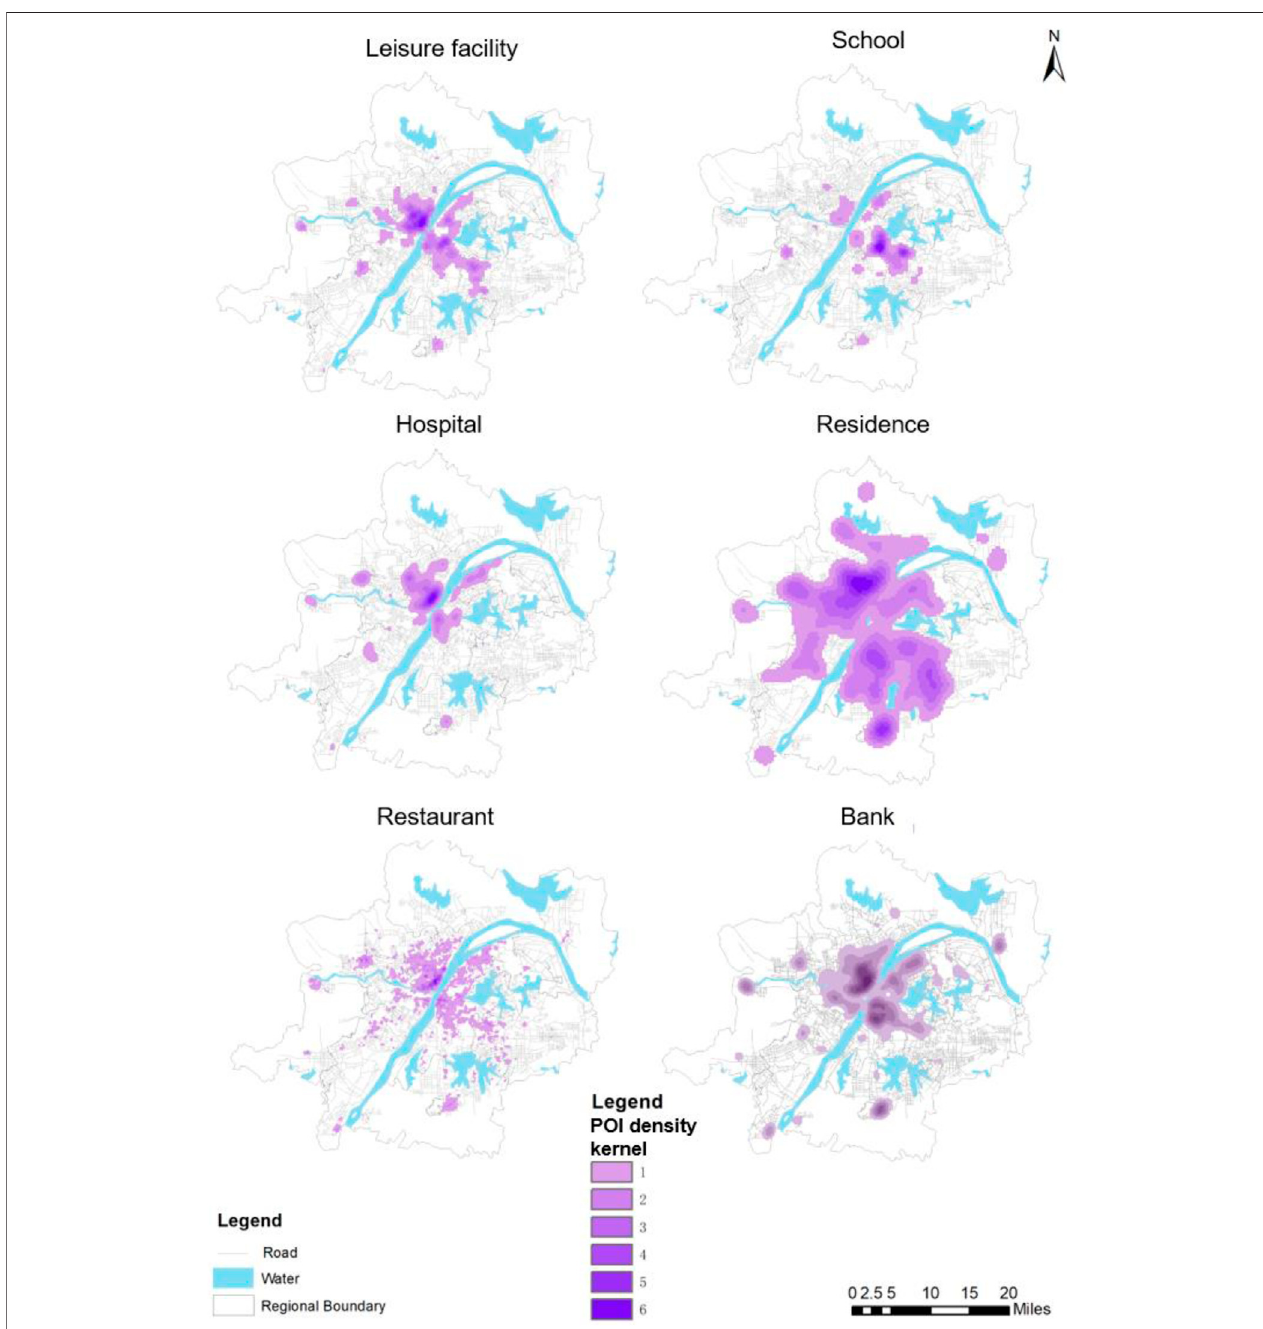
FIGURE 10 | POI clusters in